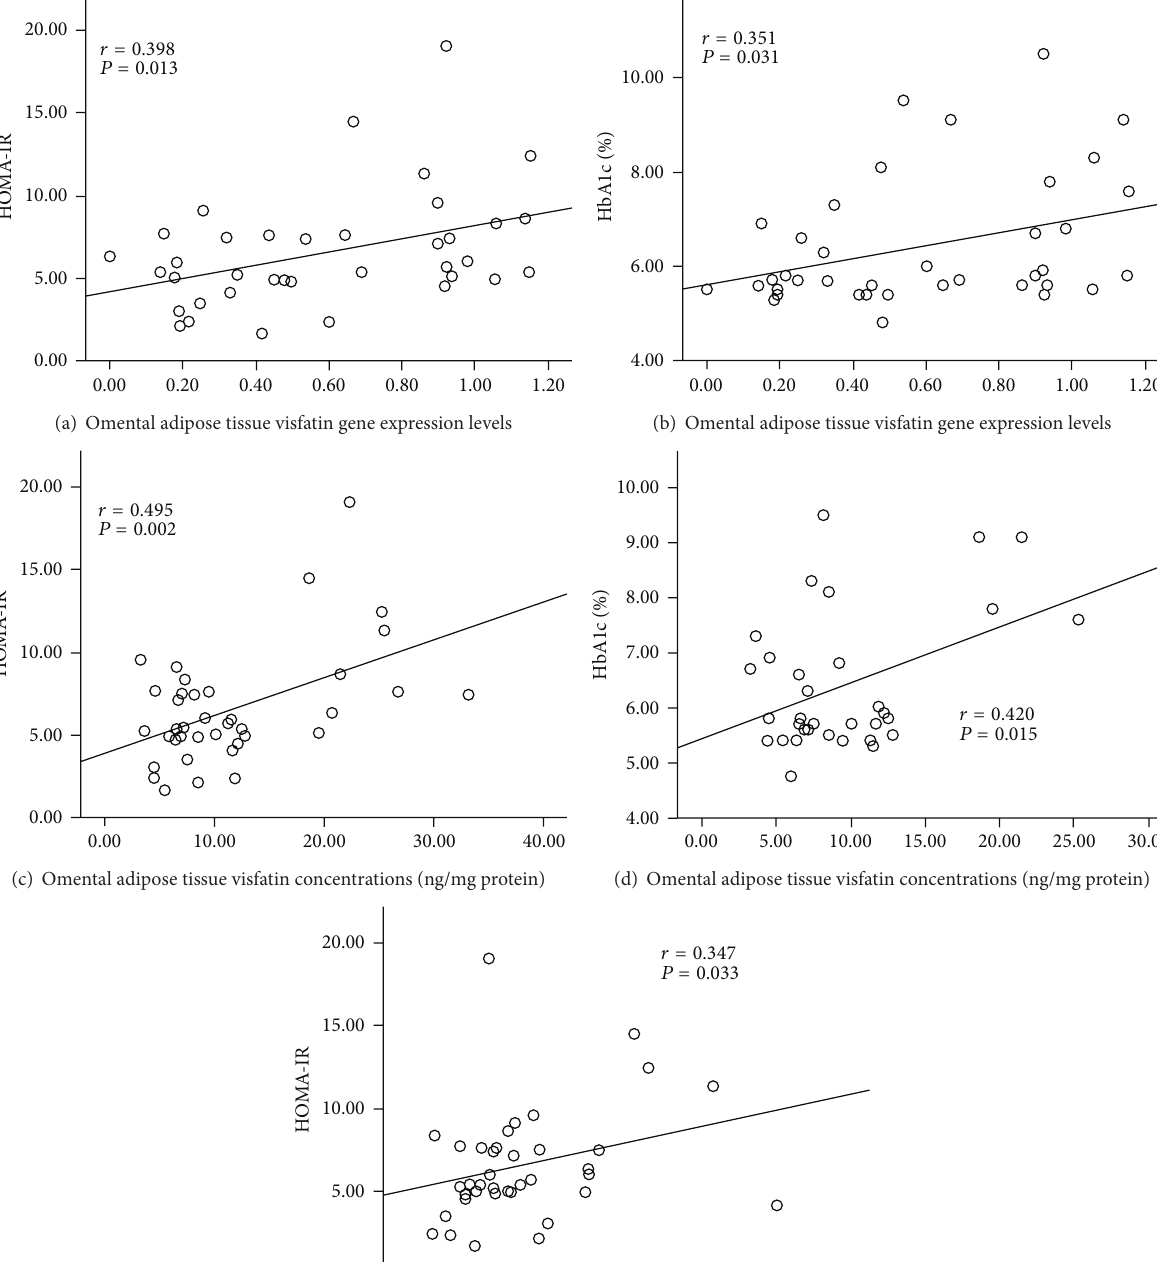
Liver had the highest RBP-4 concentrations, followed by mus- cle, subcutaneous, omental, and mesenteric adipose tissues in a decreased order (Table 3). RBP-4 concentrations in other tissues did not correlate with insulin